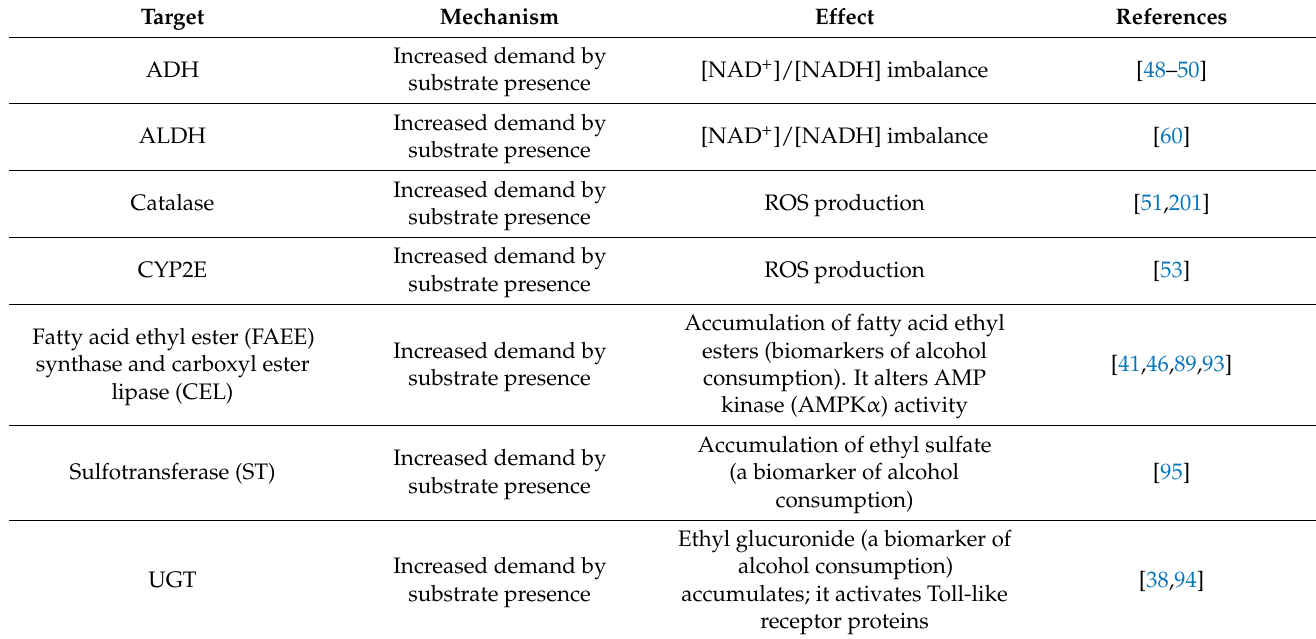
Table 2. Representative targets of ethanol and its metabolites deserving further research to establish ethanol’s participation in cancer development and progression and design new pharmacological